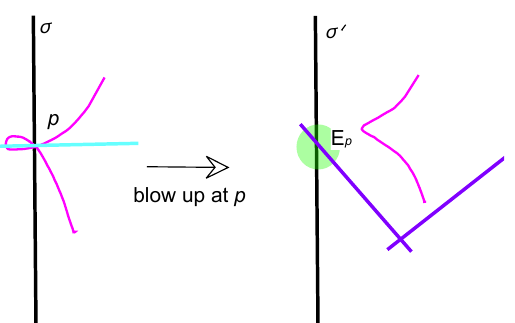
Figure 3. The location of small instanton p is the intersection between the discriminant loci D 0 and (cid:27) . Blow up at this point p in the Hirzebruch base F (1) n ! F n ejects the small instanton into the bulk. The curve (cid:27) is now transformed into (cid:27) 0 and E p .